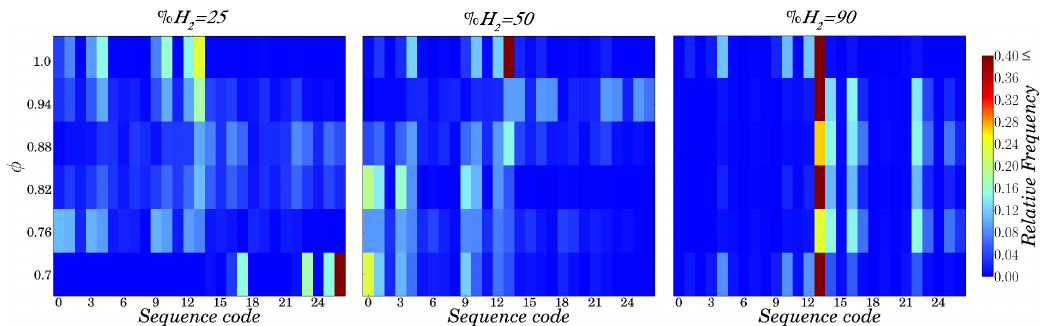
Figure 14. Frequency profiles of codes for all values for three hydrogen concentrations: ( a ) % H 2 = 25; ( b ) % H 2 = 50; and ( c ) % H 2 =